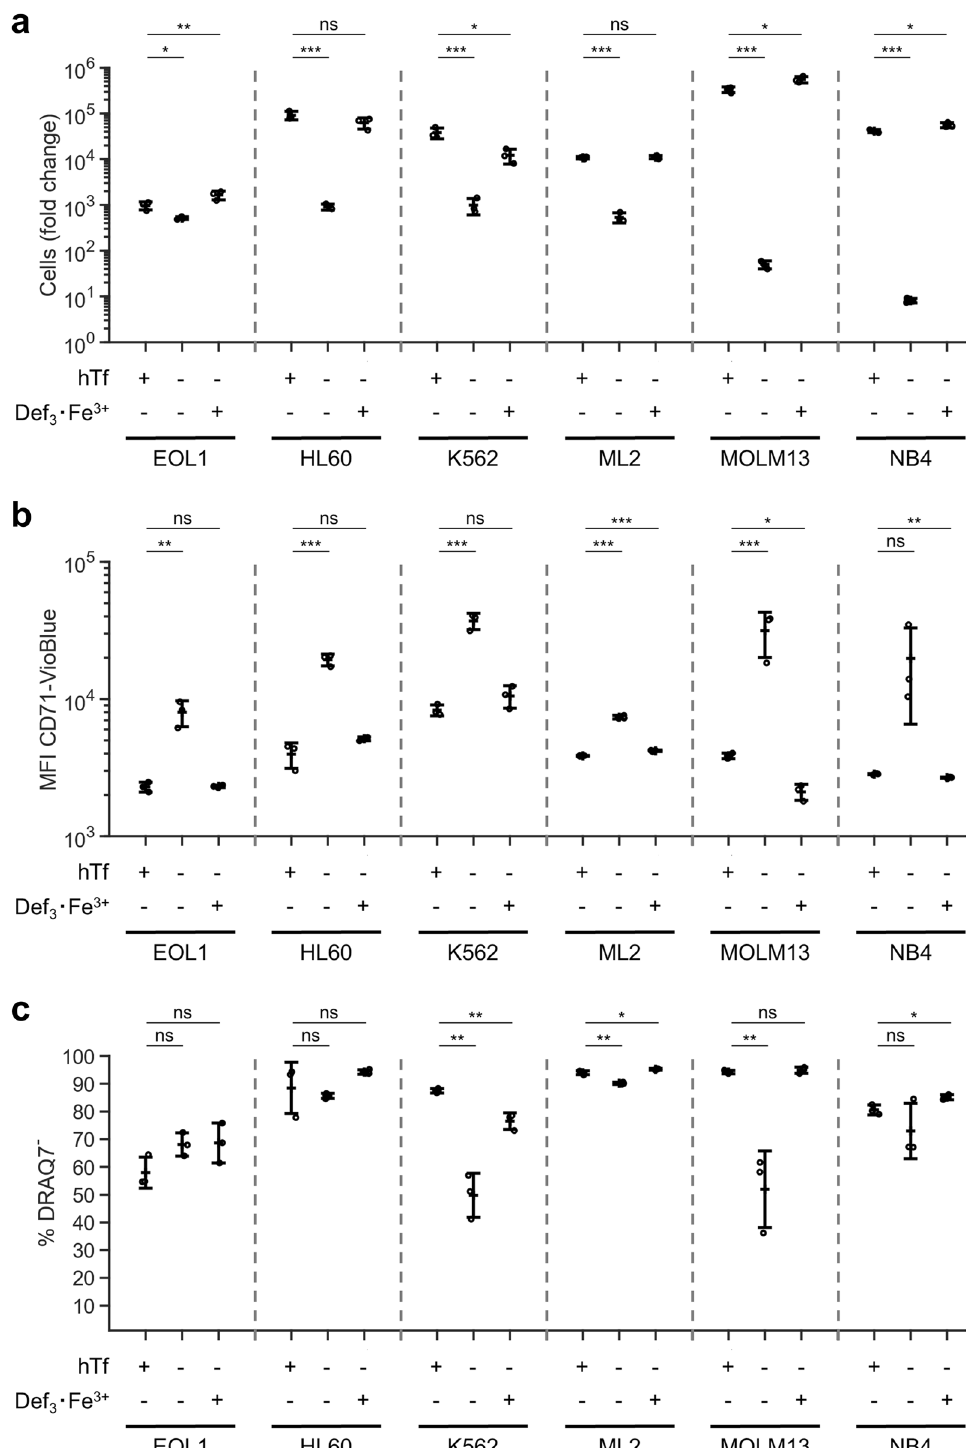
Figure 5. Deferiprone sustains expansion of selected myeloid cell lines. Myeloid cell lines were cultured in Cellquin medium supplemented or not with 300 µg/mL hTf or 52 µmol/L Def 3 ·Fe 3+ for 16 days. ( a ) Total cell number fold change relative to day 0. ( b ) Expression level of the transferrin receptor (CD71) determined by flow cytometry. MFI for corresponding isotypes is between 1 × 10 2 –3 × 10 2 . ( c ) Cells were stained with DRAQ7 (cell impermeable DNA stain) to quantify the viability of the cultures. Data is displayed as mean ± SD (error bars; individual datapoints are indicated; n = 3). Significance is shown for the comparison with 300 µg/mL hTf (unpaired two-tailed two-sample Student’s t